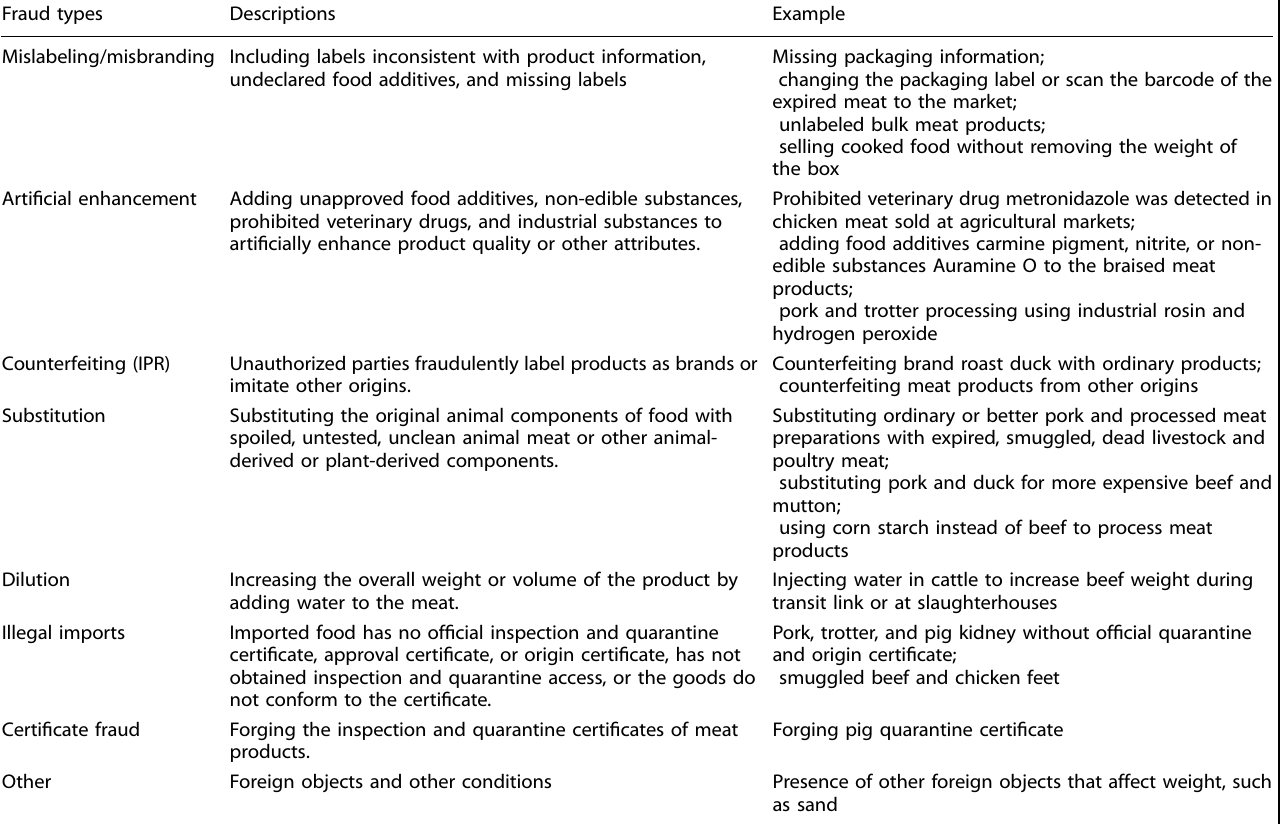
Table 9. Description of food fraud types in meat